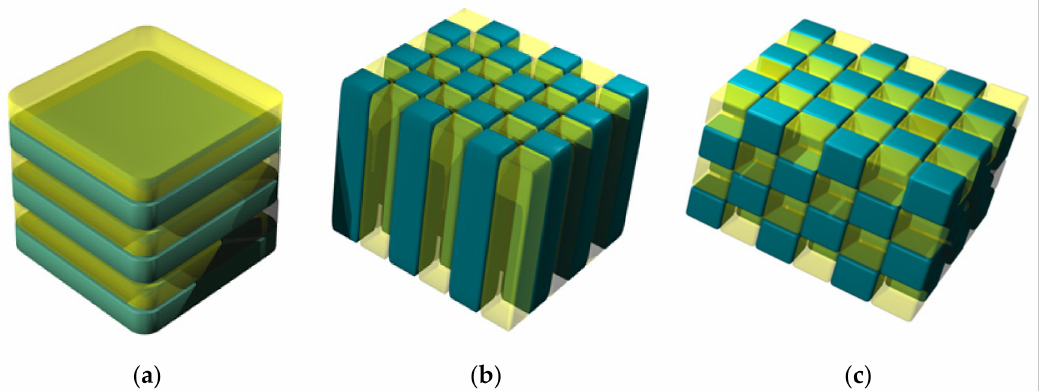
Figure 5. Basic geometries of periodic photonic crystals: ( a ) 1D structure (laminar), periodicity goes along one direction; ( b ) 2D structure–in-plane periodicity; ( c ) full 3D periodicity. Dark parts denote high refractive index regions, while light parts are regions with lower